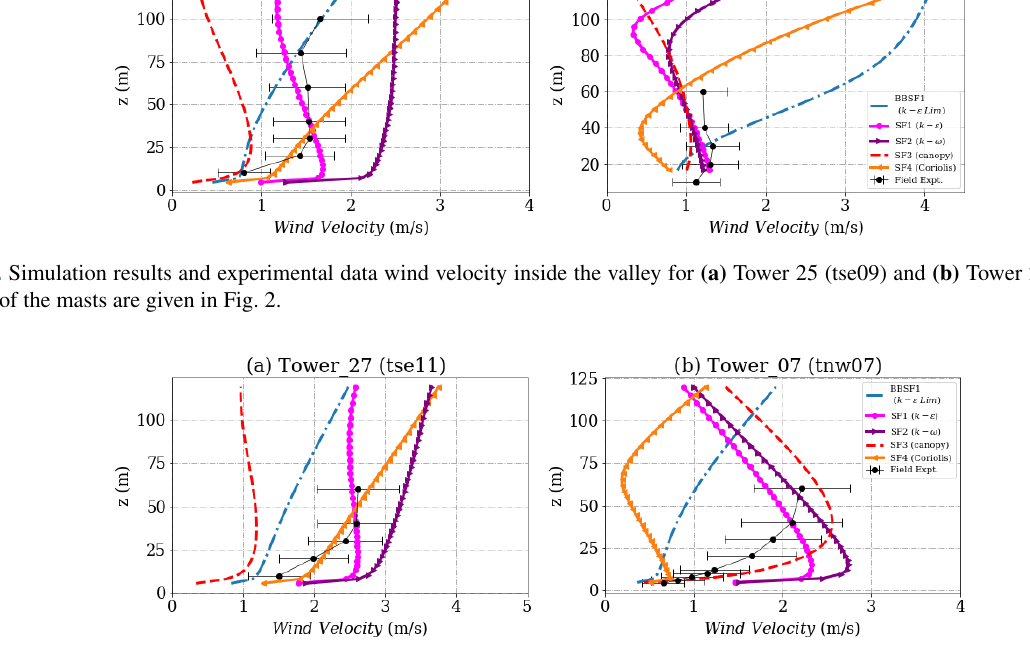
Figure 10. Simulation results and experimental data for wind velocity inside the valley for (a) Tower 27 (tse11) and (b) Tower 7 (tnw07). The locations of the masts are given in Fig.